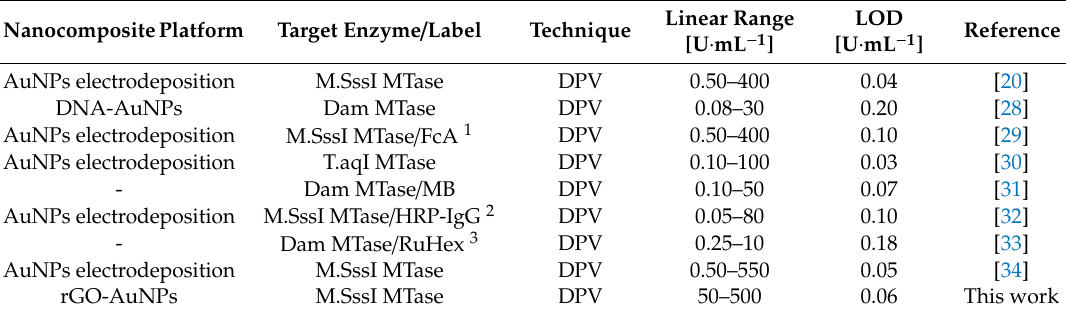
Table 1. Various study comparison in dependence of limit of detection (LOD) and nanocomposite platform used in the case of DNA methylation assays.